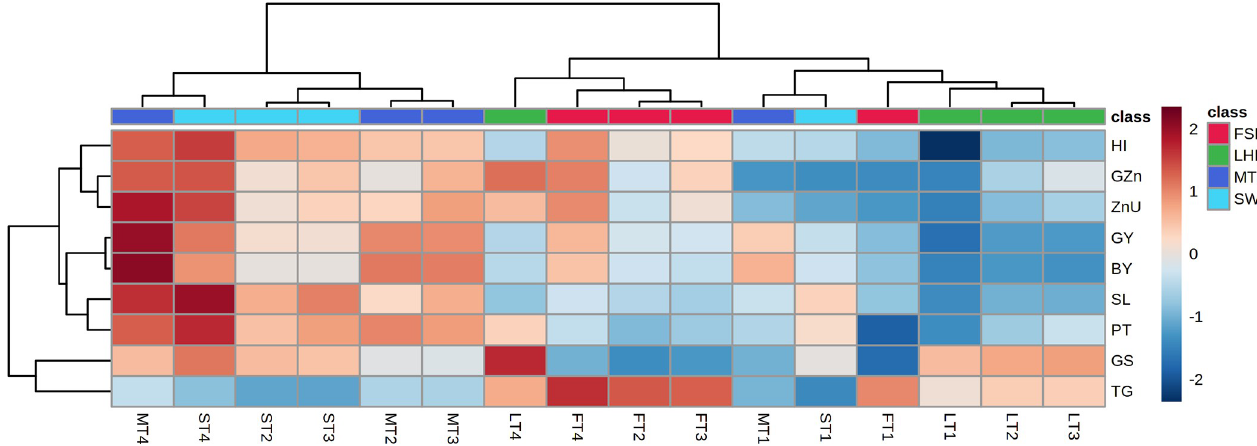
Fig 6. Heatmap showing comparison of treatments among various experimental locations for wheat. M = Multan; F = Faisalabad; S = Sahiwal; L = Lahore; BAZU = Bioactive Zn coated urea (42% N; 1% Zn); T 1 (Urea 46% N @ 185 kg ha -1 + zero Zn), T 2 (Urea 46% N @ 185 kg ha -1 + ZnSO 4 33% Zn @ 15 kg ha -1 ), T 3 (BAZU 42% N @ 100 kg ha -1 + Urea 46% N @ 62 kg ha -1 + 1% bioactive Zn @ 1.00 kg ha -1 ), T 4 (BAZU 42% N @ 125 kg ha -1 + Urea 46% N @ 62 kg ha -1 + 1% bioactive Zn @ 1.25 kg ha -1 )GZn = Grain Zn concentration; ZnU = Zn uptake by grain; GY = grain yield; BY = biomass yield; PT = productive tillers; SL = spike length; HI = Harvest index; GS = number of grains per spike; TG = thousand grain weight.